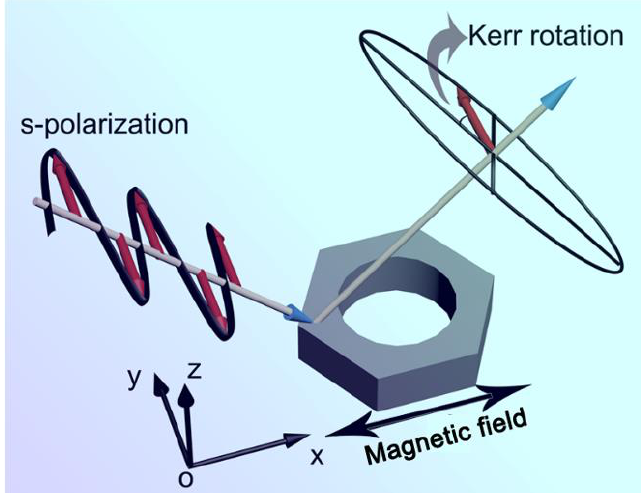
Figure 1. Longitudinal magneto-optical measurement